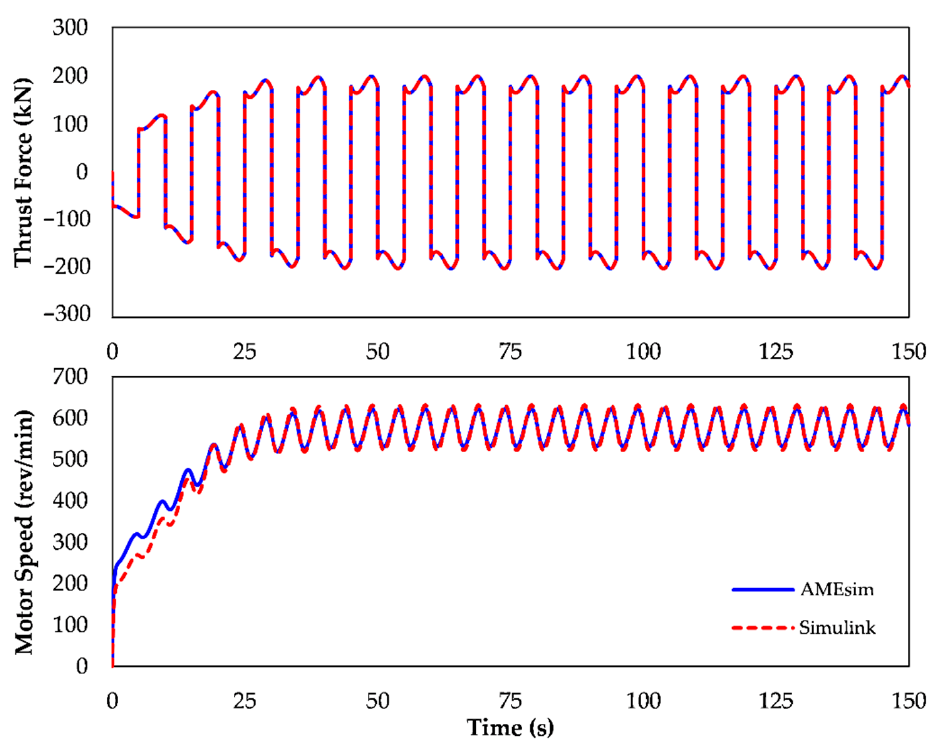
Figure 6. Conceptual design of hybrid system and wave energy converter.